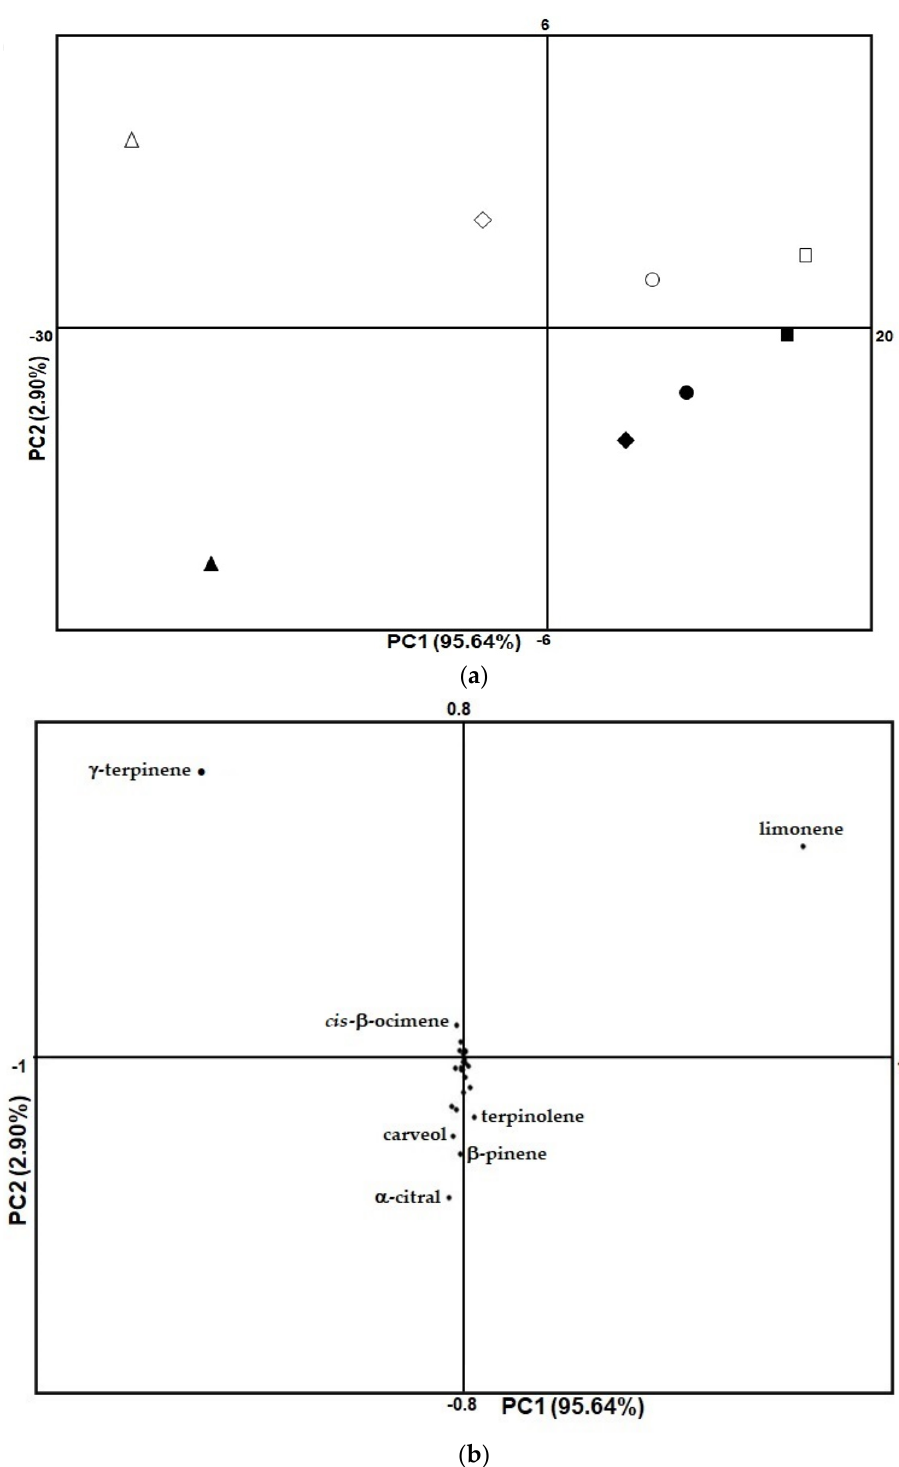
Figure 2. Score plot of citrus juice (outlined symbols) and peel (filled symbols) samples. Circle: Yuzu Jeune, square: Oni Yuzu, triangle: Florence cedar, diamond: Bizzarria orange. ( a ). Loading plot of volatile products extracted from citrus samples (juice and peel) ( b